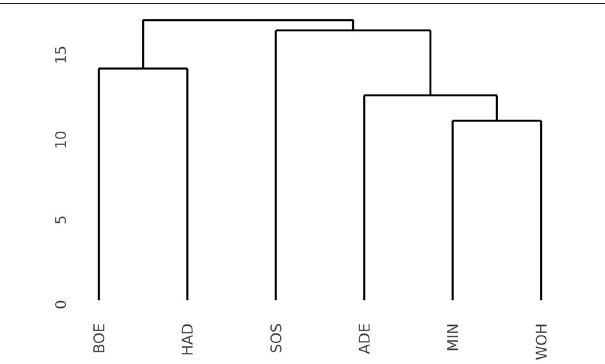
FIGURE 2 | Dendrogram based on the Euclidean distances among six locations estimated using the GCA Female -by-environment interaction effects from the grain yield trials performed in the year 2019 to assess the selection gain of the reciprocal recurrent genomic selection program. The locations were ADE, Adenstedt; BOE, Boehnshausen; HAD, Hadmersleben; MIN, Mintraching; SOS, Sossmar; WOH, Wohlde.